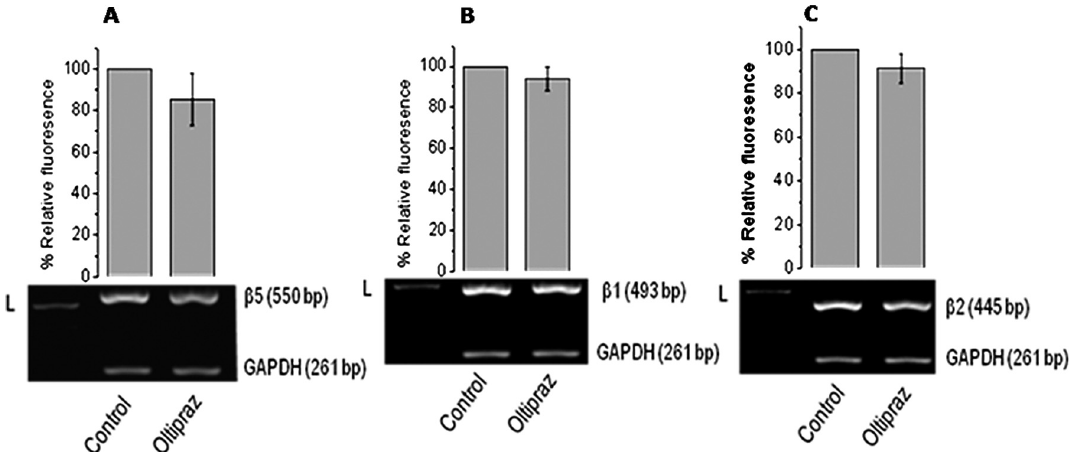
Figure 5. The effect of the activation of Nrf2 on gene expression of (A) β 5, (B) β 1, and (C) β 2 catalytic proteasome subunits in DLD-1 colon cancer cells. The mRNA levels are assessed by end-point PCR analysis. Cancer cells are incubated with Oltipraz (30 μΜ ) for 24 h.